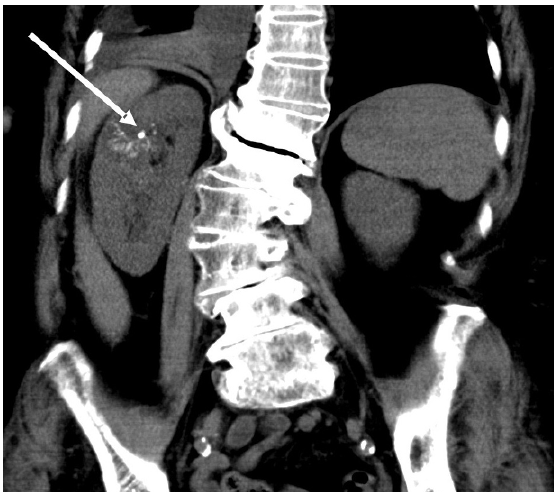
Figure 3. A follow-up computed tomography of abdominal cavity and pelvis performed in a 3-week time: a polymer-glue conglomerate was documented in a non-contrast phase of the examination (white